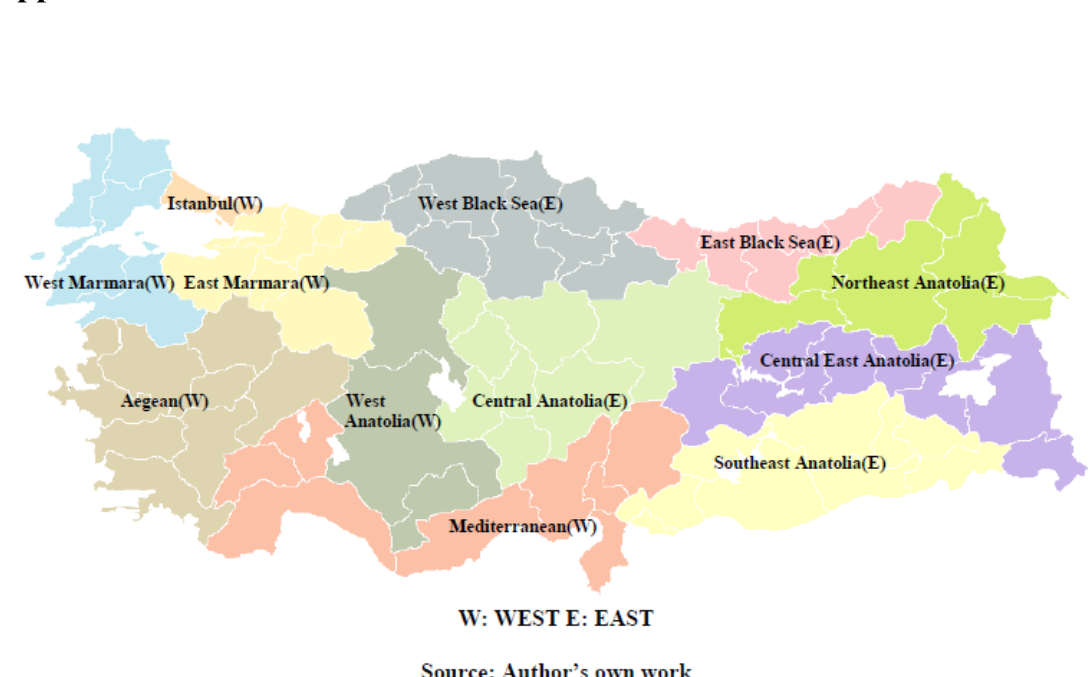
Figure B.1 : East-West